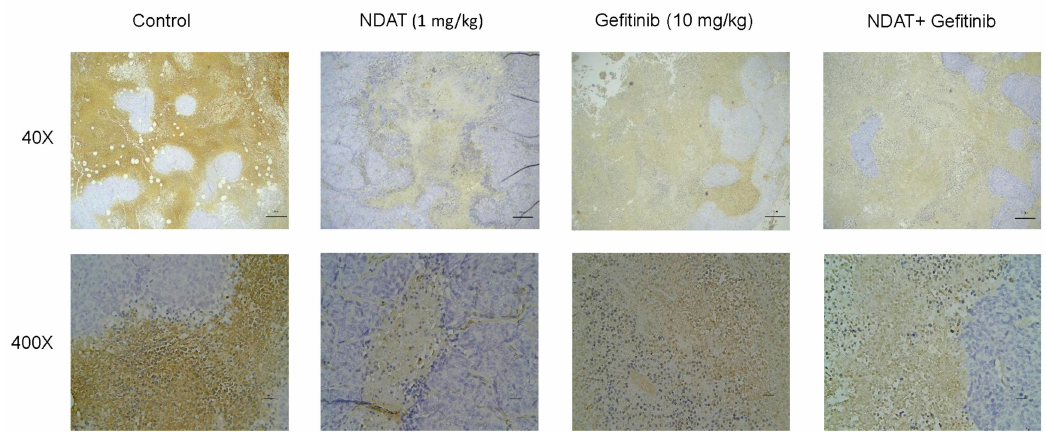
Figure 5. NDAT potentiates gefitinib-reduced PD-L1 expression in HCT116 cell-derived xenograft tumors (Table 1). The positive staining of PD-L1 is shown in brown color. The magnification is 40 × (upper panels, bar = 210 µ m) and 400 × (lower panels, bar = 21 µ